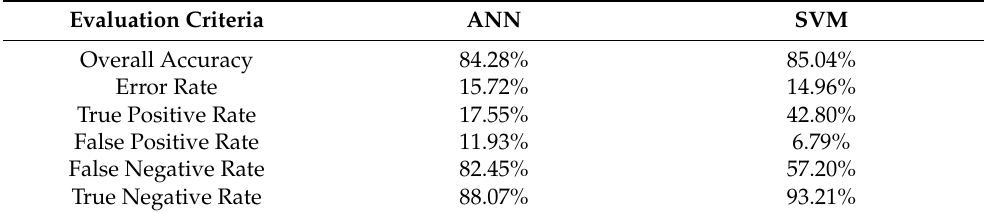
Table 4. Comparison of evaluation criteria between the classification result of the ANN and SVM compared with the ground truth data (of the